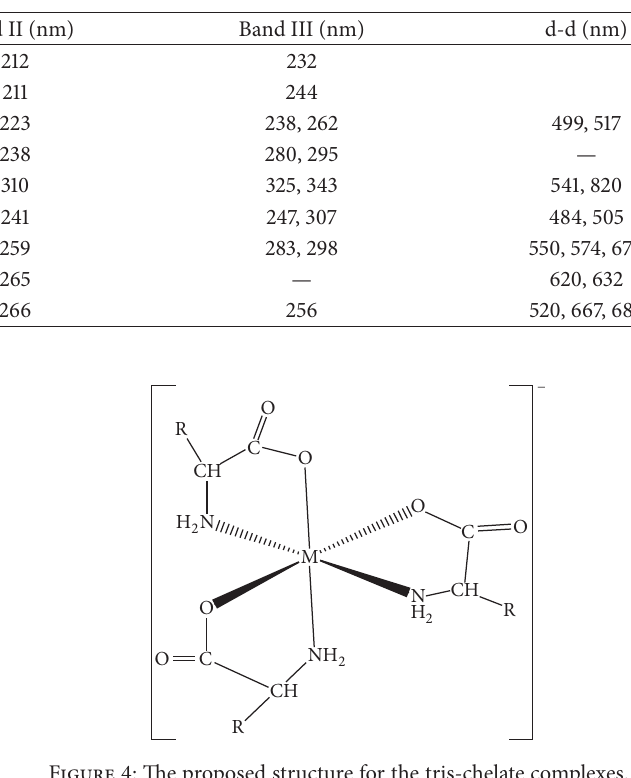
Figure 3: trans -Amine/ cis -carboxylate isomer (R = –CH 2 COOH). workers [33, 62–66]. No d - d absorption band was observed